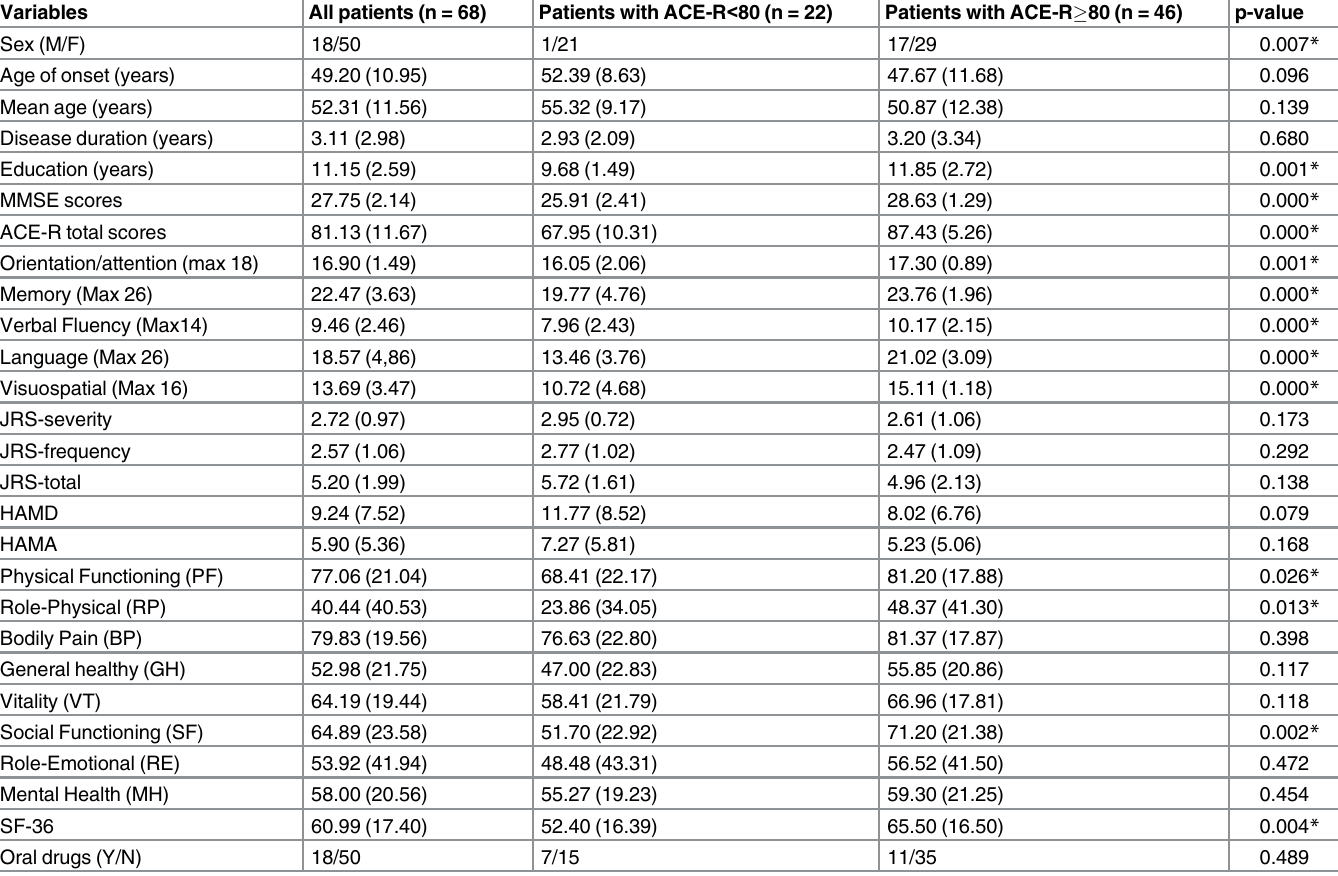
Table 1. Clinical and cognitive features of the BSP patients based on the ACE-R scores.